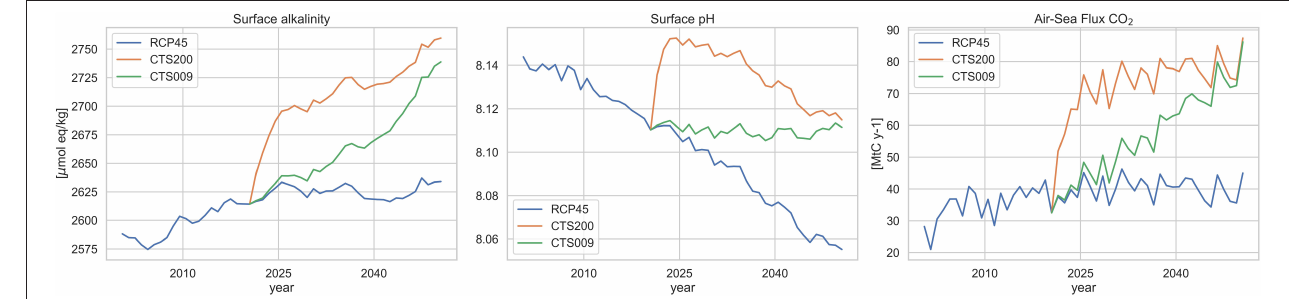
FIGURE 3 | Time series of annual mean surface alkalinity (left) , surface pH (middle) , and total annual air-sea flux (right) over the Mediterranean basin. Blue: RCP4.5 baseline projection, orange: CTS200 projection, green: CTS009